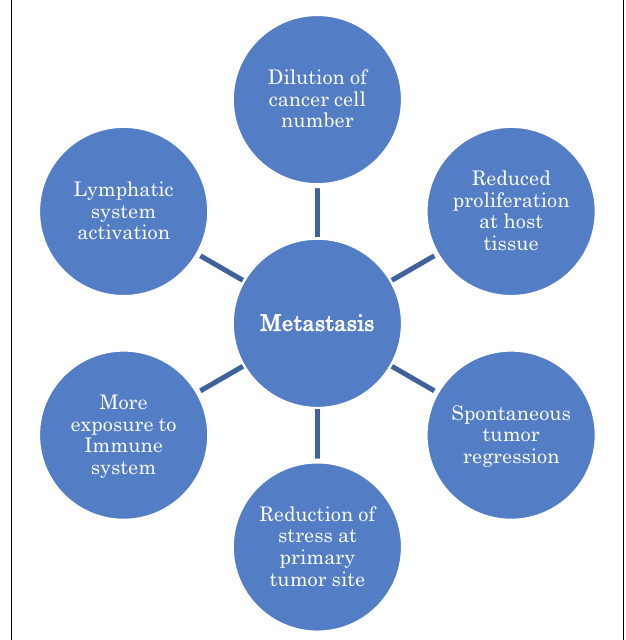
FIGURE 1 | A simple model to illustrate that how metastasis is helpful for the body .